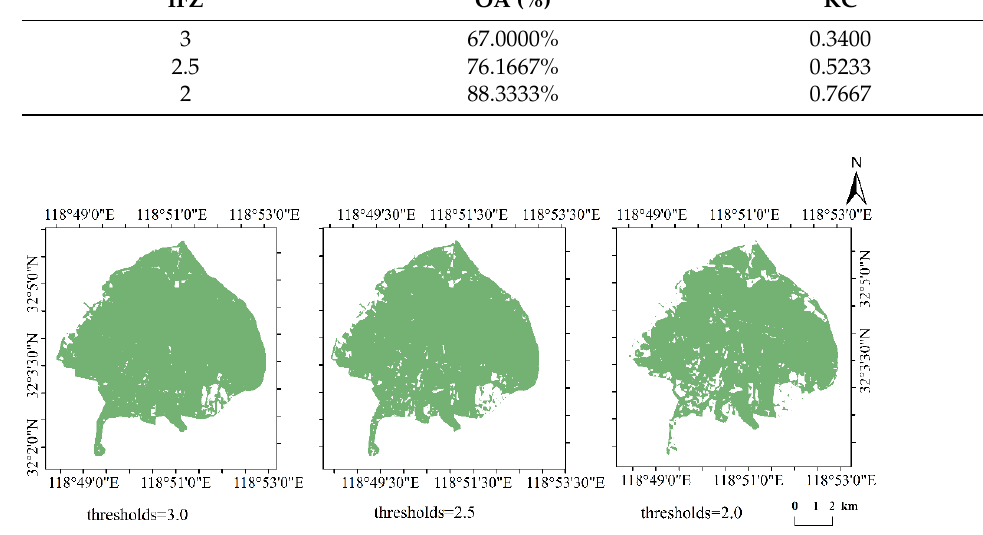
Figure 3. Forest extraction results of different thresholds for IFZ index of GF-5 image.